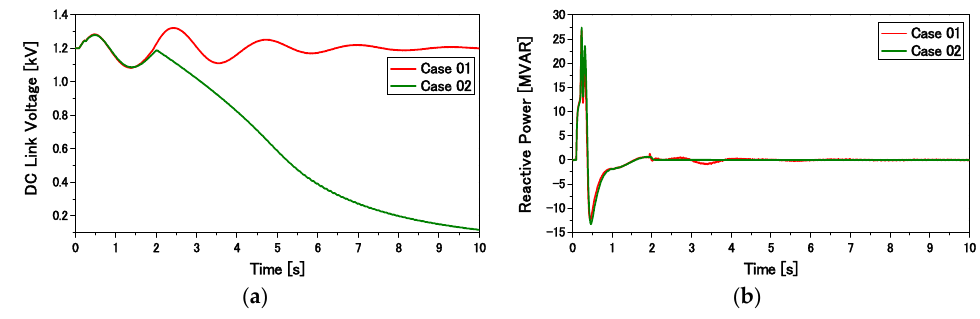
Figure 20. Active power output of wind generators: ( a ) DFIG; ( b ) SCIG.